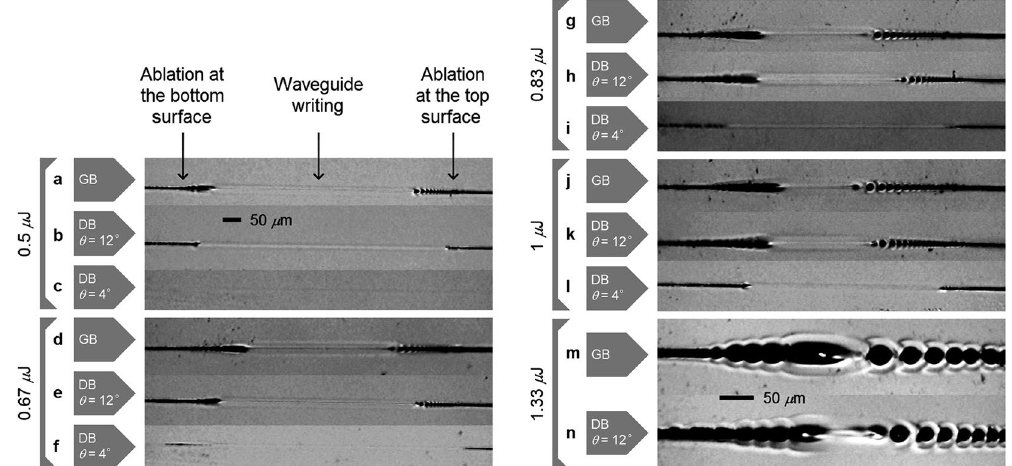
Figure 5. The DB technique limits detrimental surface ablation. Top view of diagonally laser written lines from the top to the bottom surface of a 100 μ m thick flexible glass sheet. The results show that using the Dual-Beam (DB) technique with θ = 12° ( b , e , h , k and n ) and θ = 4° ( c , f , i and l ) it is possible to write waveguides closer to the glass surface compared to the conventional Gaussian beam (GB) focusing ( a , d , g , j and m ). The laser was focused with 0.5 μ J pulses ( a , b and c ), 0.67 μ J pulses ( d , e and f ), 0.83 μ J ( g , h and i ), 1 μ J ( j , k and l ) and 1.33 μ J ( m and n ). The 50 μ m scale in ( b ) is the same from ( a ) to ( l ) and the scale in ( m ) is also valid for ( n ). The contrast has been enhanced to make the features